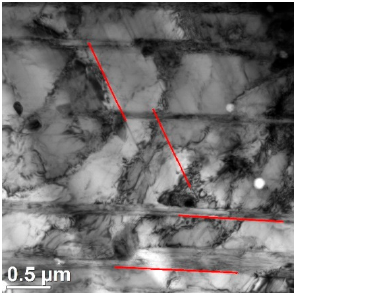
Figure 3. Co-SLS alloy sample structure. ( a ) Transmission Electron Microscopy Bright Field (TEM-BF) image, red lines indicate stacking faults (SF) and ε phase bands in the γ matrix; ( b ) Scanning Transmission Electron Microscopy High Angle Angular Dark Field (STEM-HAADF) image, blue arrows indicate nanoprecipitates of elongated shape, green arrows indicate spherical precipitates.